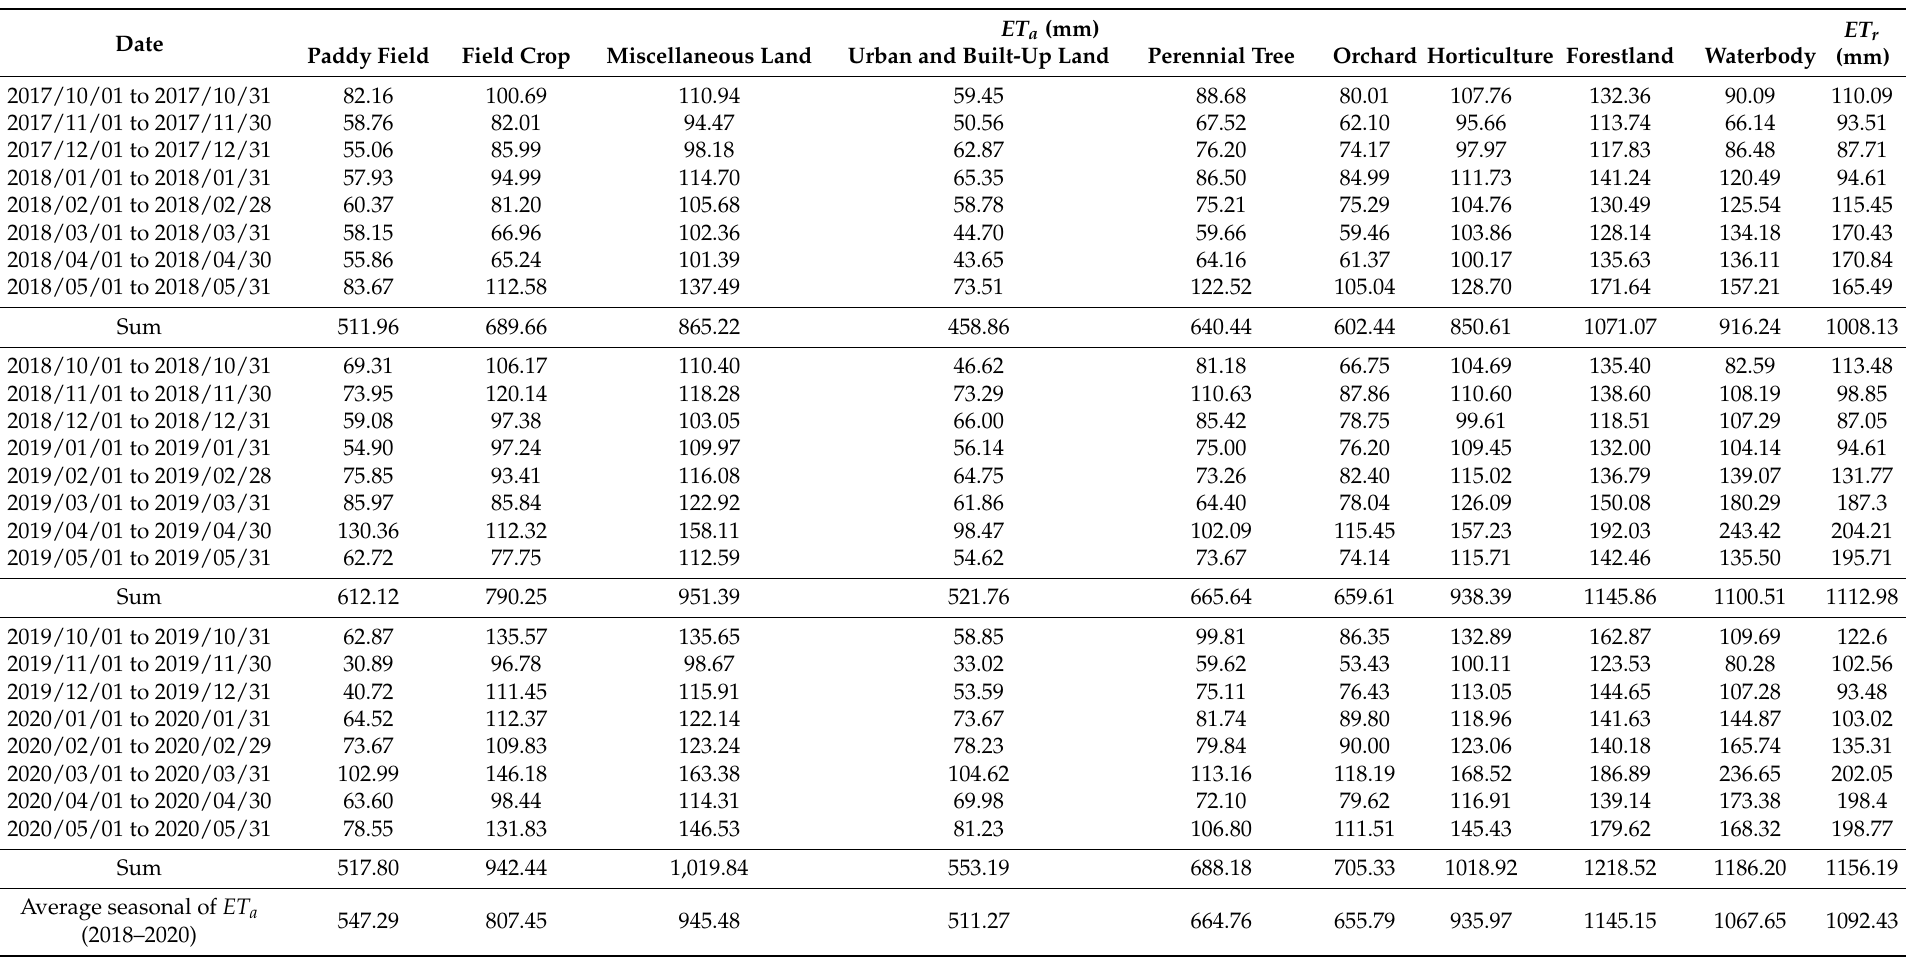
Table 6. Accumulated monthly and seasonal ET a values for various land-use types and ET r in the study area during the dry seasons of 2018, 2019, and